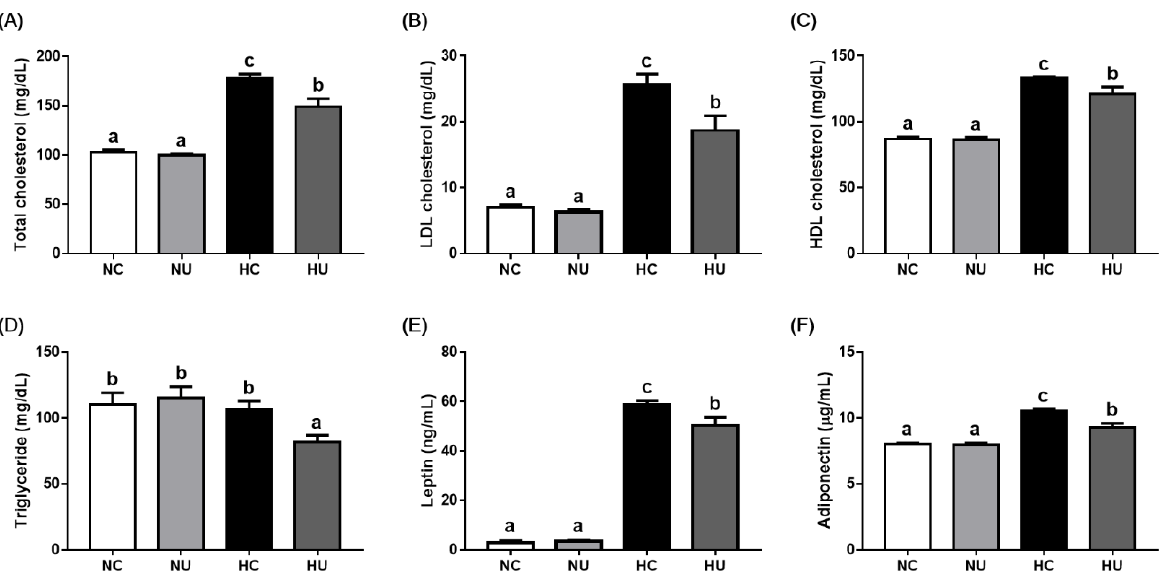
Figure 3. Effects of Bacteroides uniformis CBA7346 treatment on serum lipids and hormones in mice with high-fat diet- induced non-alcoholic fatty liver disease. ( A ) Serum total cholesterol; ( B ) serum LDL cholesterol; ( C ) serum HDL cholesterol; ( D ) serum triglyceride; ( E ) serum leptin; ( F ) serum adiponectin. NC, control group on normal diet; NU, group on normal diet receiving 1 × 10 6 CFU B. uniformis CBA7346 thrice a week; HC, control group on high-fat diet; HU, group on high-fat diet receiving 1 × 10 6 CFU B. uniformis CBA7346 thrice a week. Data are presented as mean ± SEM ( n = 9). Means with different letters (a–c) indicate significant difference ( p < 0.05) among groups. Groups were compared using Duncan’s multiple range tests.